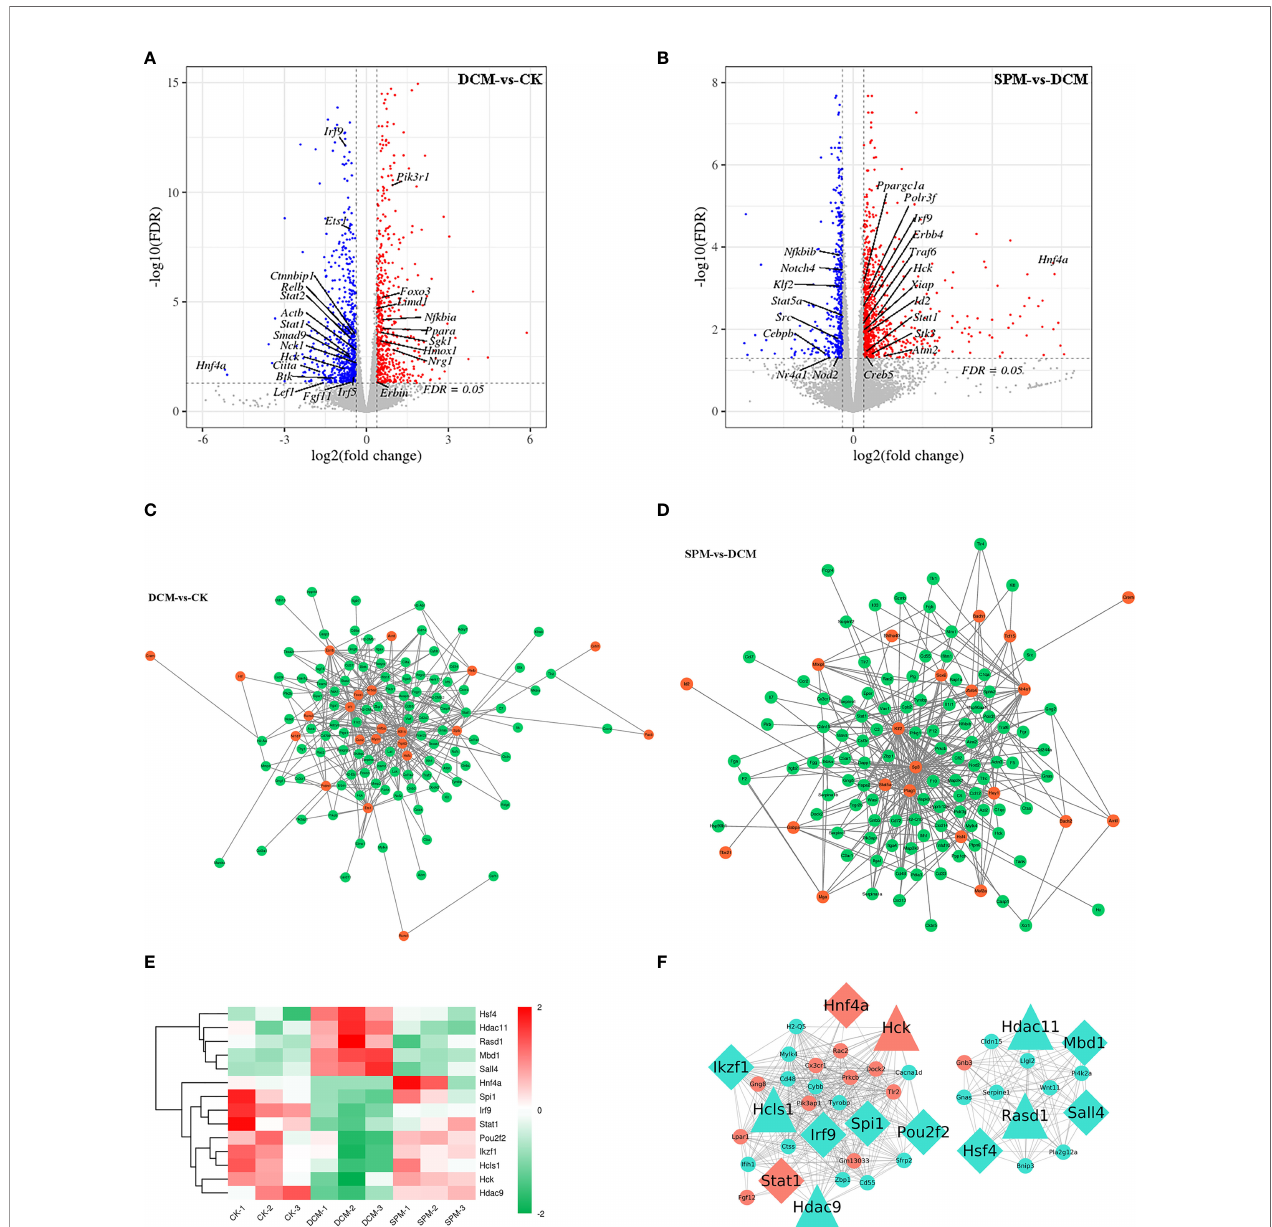
FIGURE 6 | Prediction of transcription factors and its co-factors target RNAs. Tagging the differentially expressed transcription factors (TFs) and its co-factors of (A, B) DCM compared to CK group and SPM compared to DCM group on volcano plot. Network diagram suggests the TFs and its co-factors with their predicted target genes of (C) DCM compared to CK group and (D) SPM compared to DCM group. (E) Heat map shows the hierarchical clustering of the TFs and its co- factors that were up- or downregulated in DCM and reversed by SPM. Color red and green represent up- and downregulated genes, respectively. (F) Cytoscape diagram shows the correlation between the TFs and its co-factors and the DEGs in immunity and signal transduction pathways. Diamond represents TFs, triangle represents TFs co-factors, and circle represents other genes in the immunity and signal transduction pathways. Color orange represents genes in our concerned pathways, such as PI3K-Akt signaling pathway, and chemokine signaling pathway. Color turquoise represents other